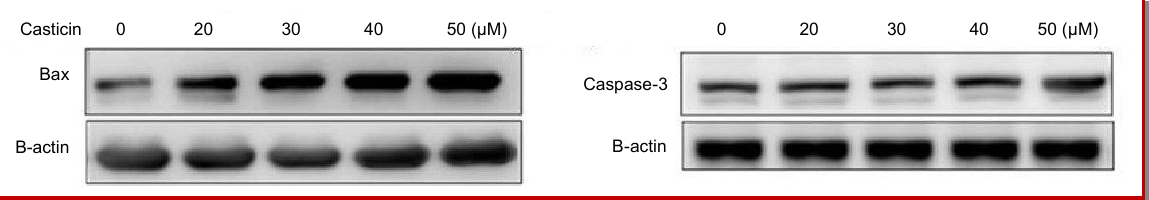
Figure 4: Casticin increased the population of cells in the S phase of cell cycle with subsequent reduction in G1 phase. The cells were analyzed by flow cytometry after treatment with casticin for 48 hours